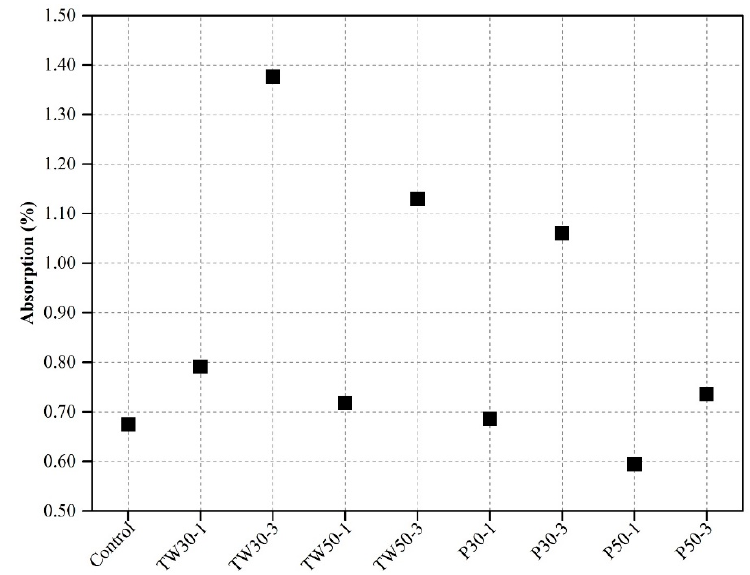
Figure 7. Absorption ability of specimens.